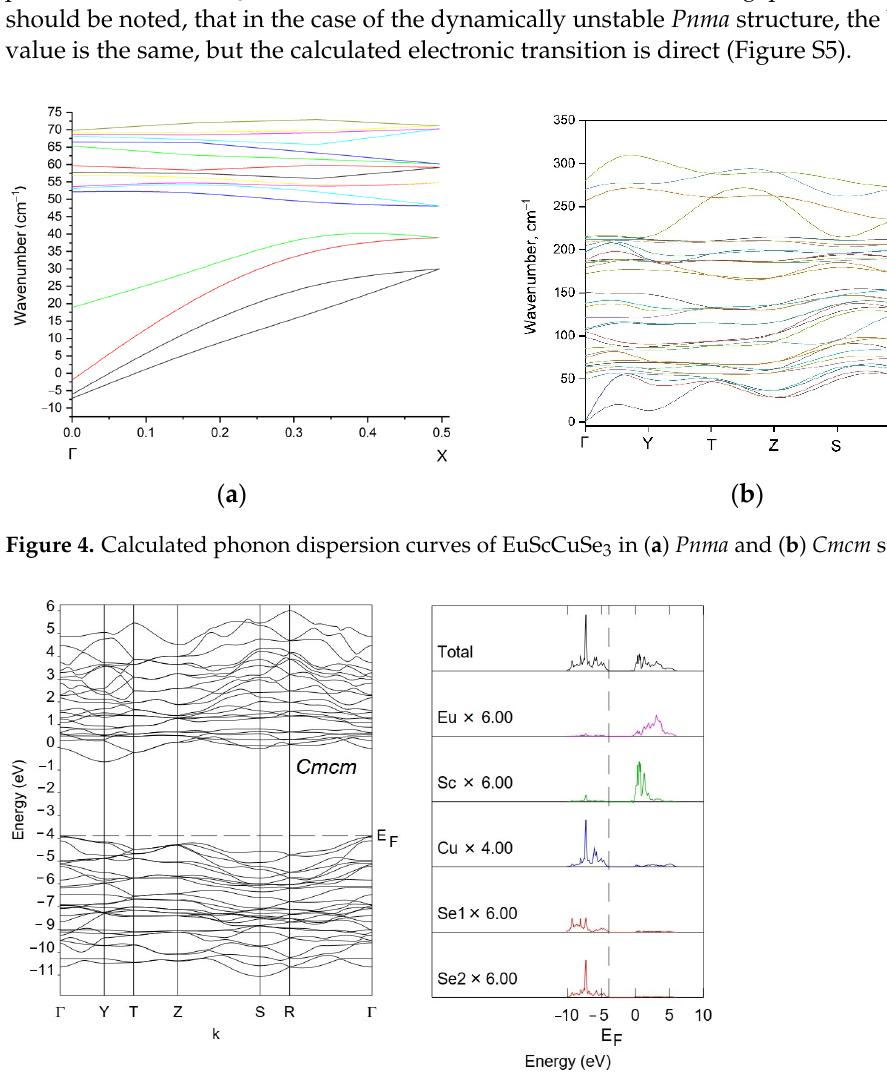
Figure 4. Calculated phonon dispersion curves of EuScCuSe 3 in ( a ) Pnma and ( b ) Cmcm structures.